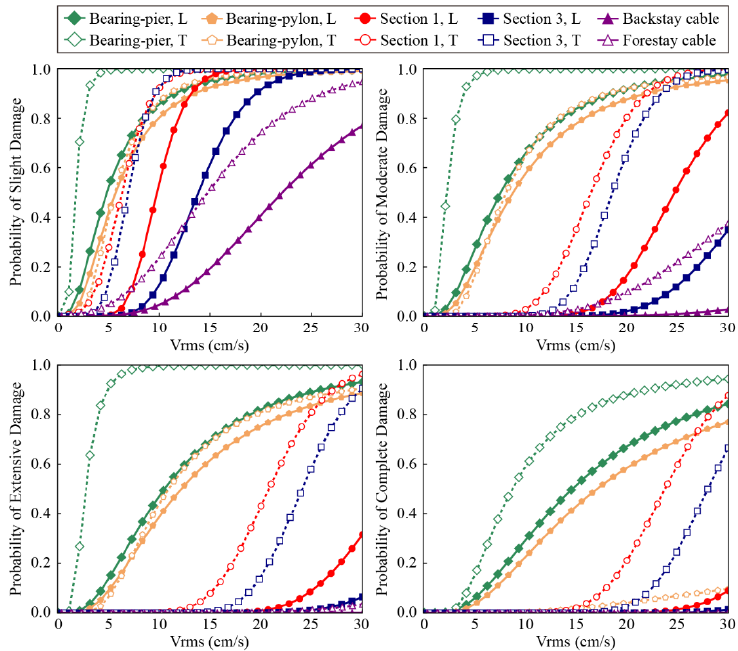
Figure 12. Component fragility curves for the fault-crossing bridge.